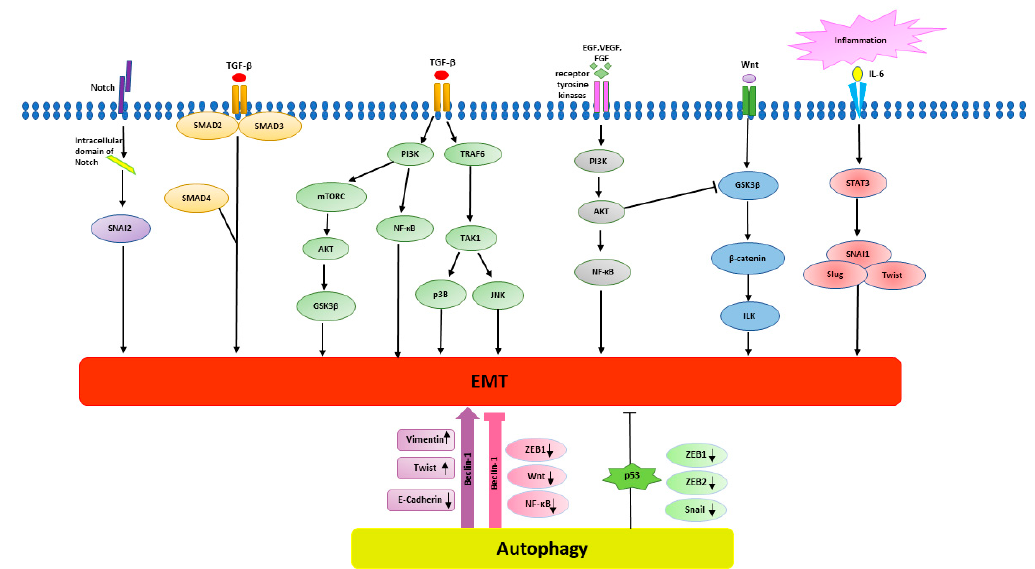
Figure 2. Cross-link between EMT-induced signalling pathways and Autophagy-inducedsignalling pathways. EMT-mediated signalling pathway includes Notch, TGF- β , receptor tyrosine kinases, Wnt, and inflammatory pathways. TGF- β signalling complies with SMAD2 and SMAD3to lead to EMT. TGF- β signalling also activates PI3K-mTOR-AKT-GSK3b pathway to induce EMT. Wnt signalling drives EMT through GSK3 β inhibition and β -catenin stabilization. Wnt, Notch and inflammatory pathways induce EMT by activation of EMT transcription factors, including SNAI1, β -catenin, Twist and Slug. Receptor tyrosine kinases activate PI3K-ATK pathway via activation of growth factors, such as EGF, VEGF and FGF. Autophagy triggers EMT by up-regulating mesenchymal markers including vimentin and Twist and down regulating epithelial marker E-cadherin through Beclin-1 pathway. Beclin-1 pathway can activate autophagy to suppress EMT via down-regulating EMT transcription factors, such as ZEB1 and inhibiting Wnt and NF- κ B pathway. P53 inhibits EMT by decreasing the expression of EMT transcription factors, such as ZEB1/ZEB2, Snail.